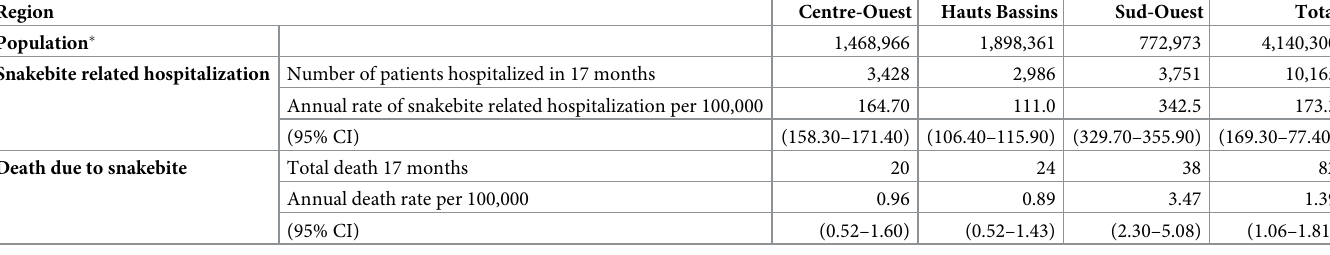
Table 2. Hospitalisation and death of snakebite victims over 17 months period between June 2013 and October 2014.